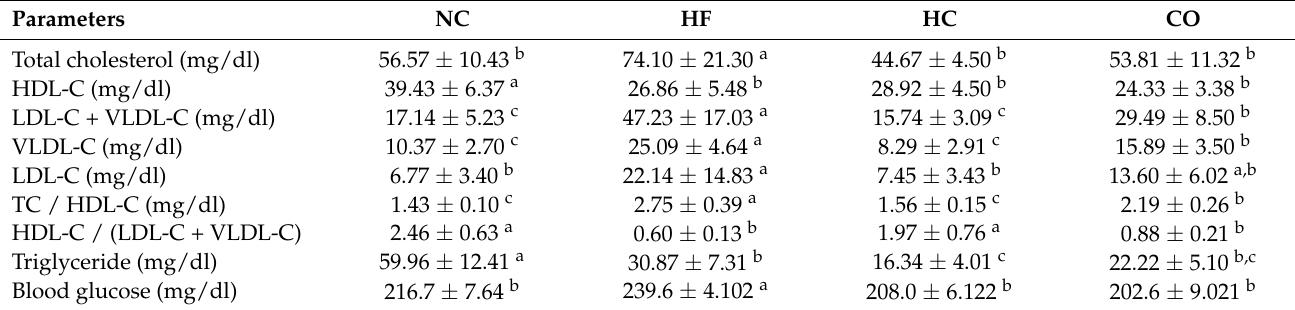
Table 3. The changes in plasma biochemical indexes in rats fed with different experimental diets for 12 weeks. Parameters